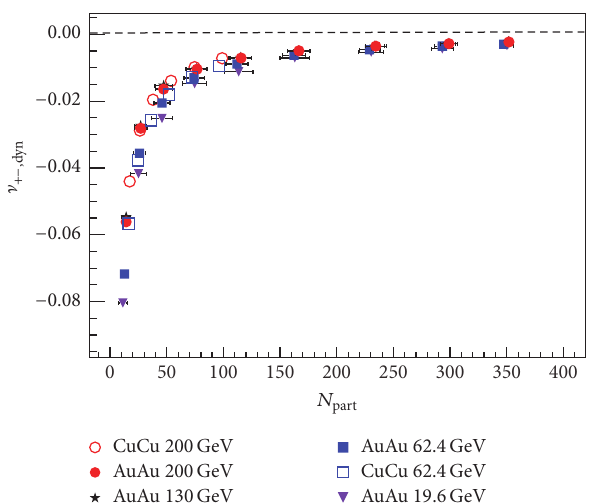
Figure 4: Centrality ( 𝑁 part ) and collision energy dependence of dynamical net-charge fluctuations, ] (+−, dyn ) , of particles produced within pseudorapidity |𝜂| < 0.5 in Cu + Cu and Au + Au collisions at RHIC [51]. The combined (statistical and systematic) uncertainties are within the symbol